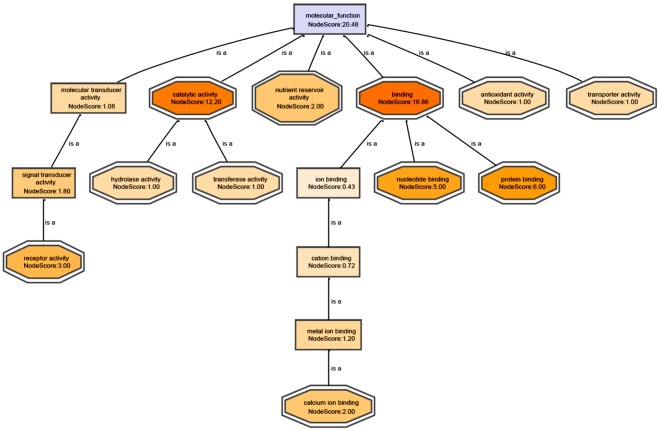
Pathway analysis of the target of Dufulin in mediating anti-viral responses using MF-DAG.Nodes are colored according to their score values. The DAGs of BP and CC are shown in Figures S7 and S8.